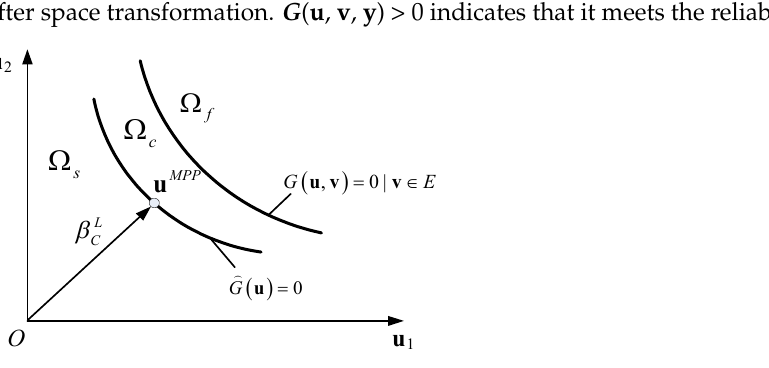
Figure 2. Comprehensive reliability index in u space.